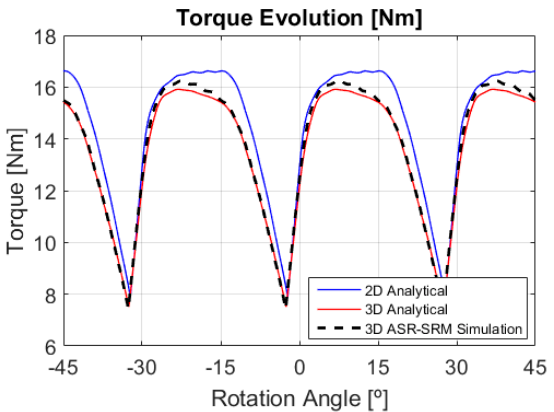
Figure 5. Torque-angle characteristics for the 2D analytical superposition (blue line), 3D analytical superposition (red line), and 3D ASR-SRM (dashed black line).